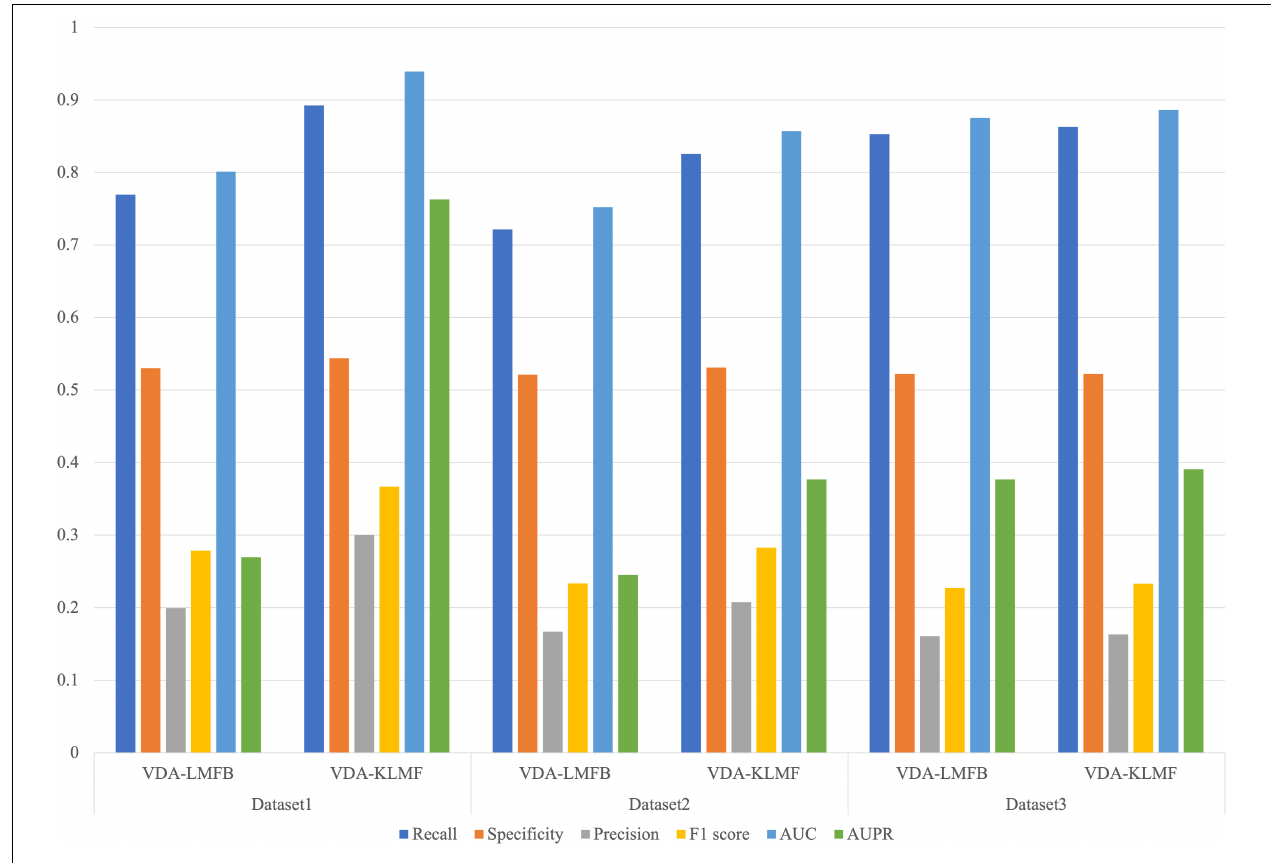
FIGURE 4 | Effect of Gaussian kernel on virus-drug association prediction